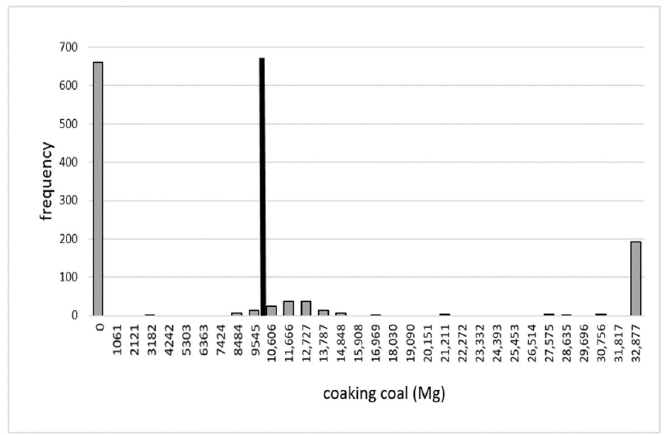
Figure A21. Histogram showing frequencies of achieving given quantity of sales of coking coal (“Export 2”) for mine “E” with σ yprog .